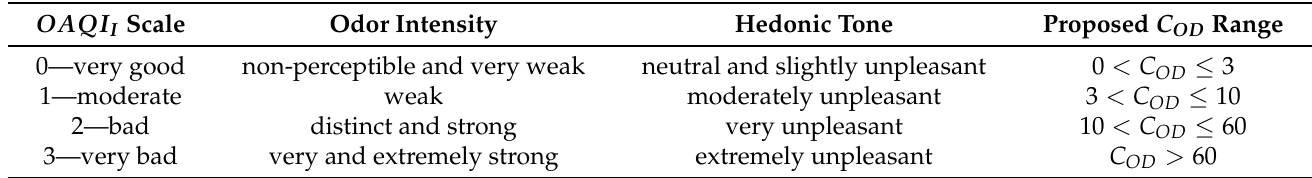
Table 4. Proposed odor air quality index ( OAQI I ) scale and its